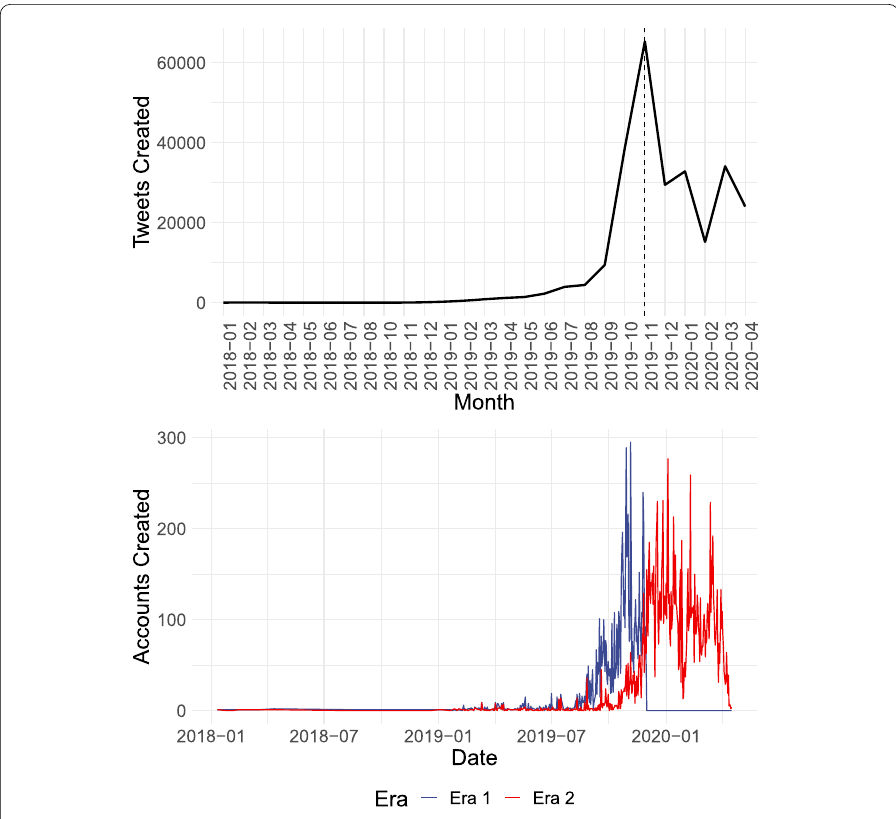
Figure 1 Tweet creation and account creation times of state-sponsored accounts. Top: A spike in tweet creation is observed in November 2019. Bottom: Accounts active before the spike (Era 1) are older than those active after it (Era 2)